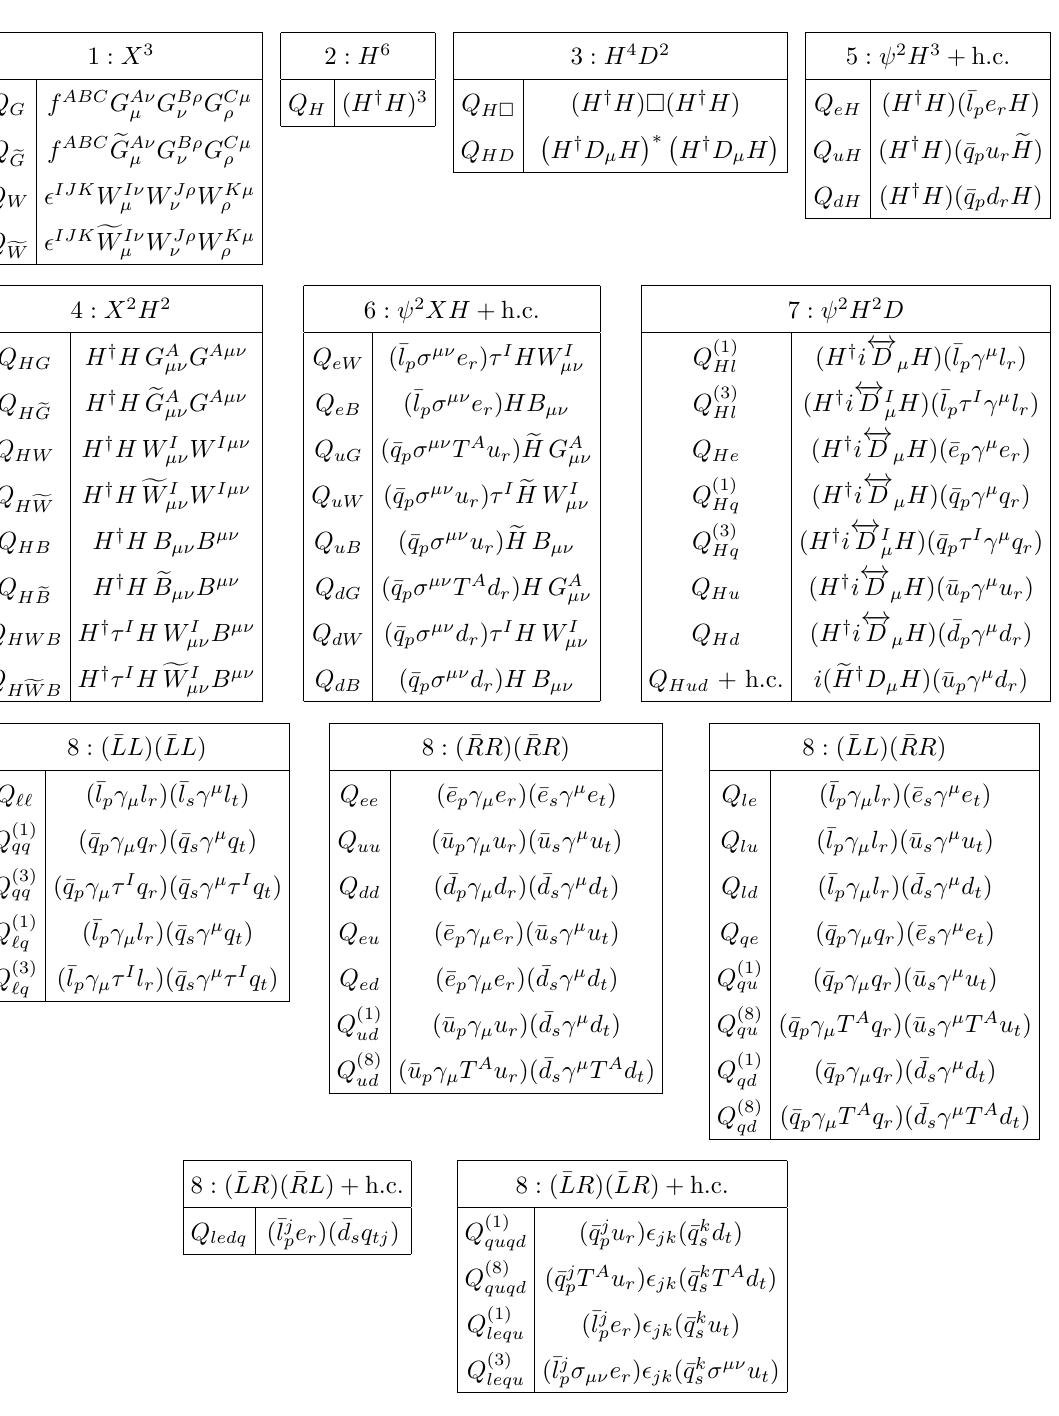
Table 3 . The independent dimension-six operators built from Standard Model (cid:12)elds which conserve baryon number, as given in ref. [9]. The (cid:13)avour labels p; r; s; t on the Q operators are suppressed on the left hand side of the